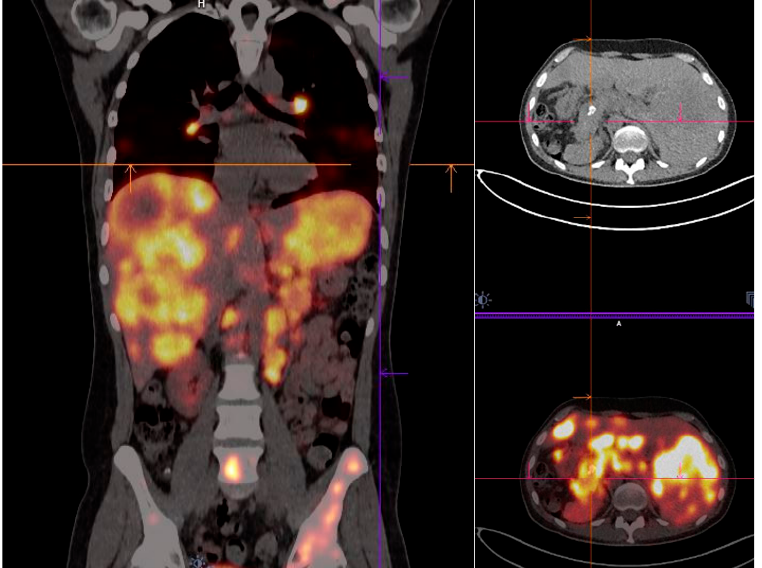
Figure 4. [ 64 Cu]Cu-DOTA-TOC PET/CT: A 36-year-old gentleman with NET of the pancreas with